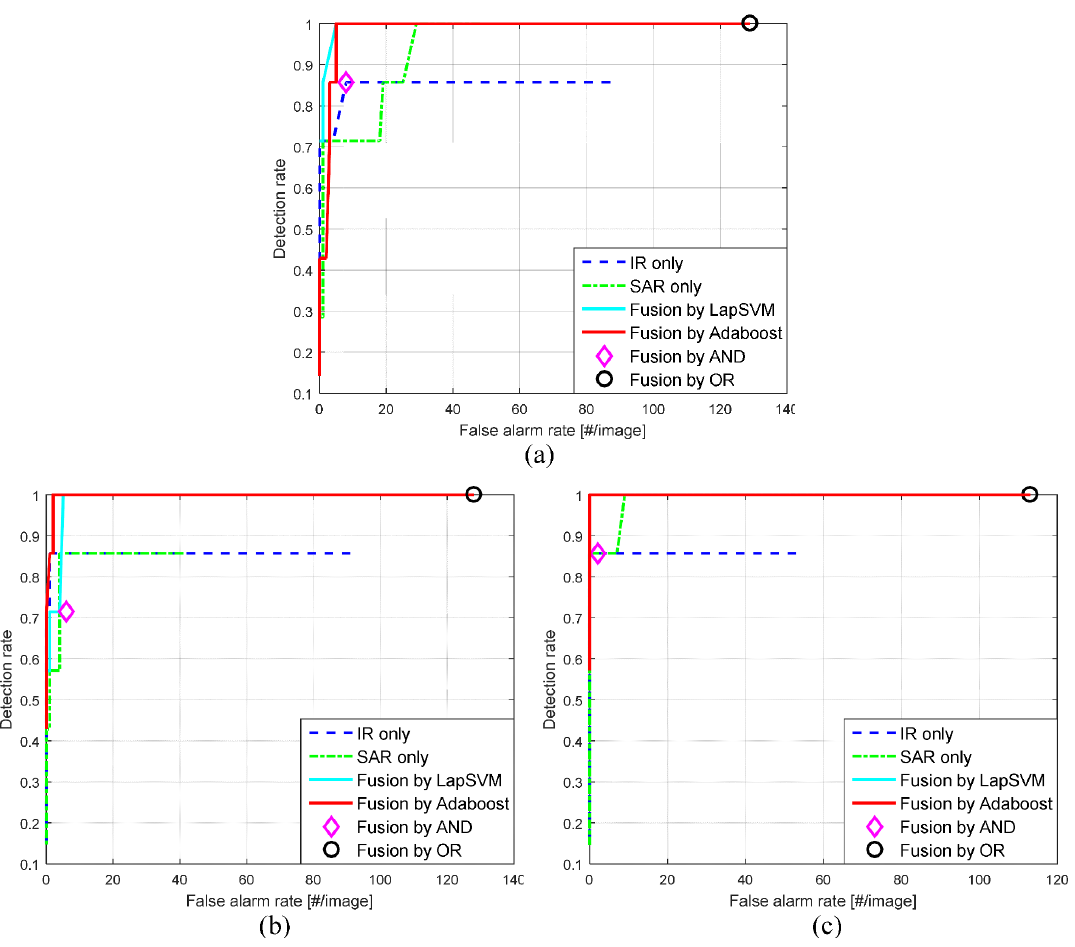
Figure 27. Comparison by ROC curves: ( a ) result of a test image, BG1-T7-IR/SAR; ( b ) result of an test image, BG2-T7-IR/SAR; ( c ) result of an test image,